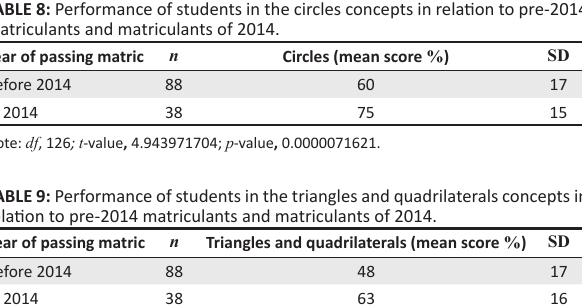
TABLE 7: Performance of students in the line concepts in relation to pre-2014 matriculants and matriculants of 2014. Year of passing matric n Lines (mean score % ) SD Before 2014 88 64